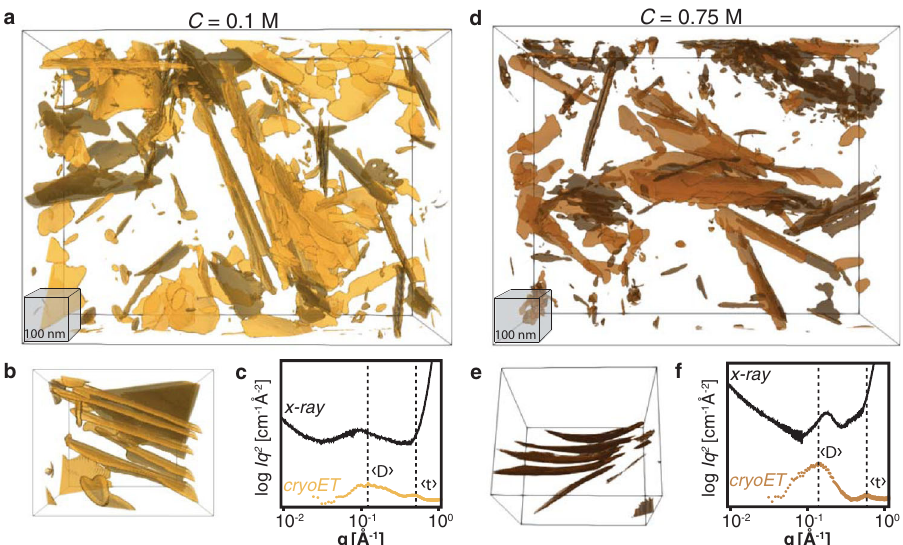
Fig. 3 Li-Mt suspensions viewed with cryoET. Isosurfaces of Li-Mt layers in 0.1 M ( a ) and 0.75 M ( d ) lithium chloride. b , e Subvolumes from ( a ) and ( d ), showing osmotic hydrate stacks. Comparison of structure factors from X-ray scattering and cryoET in 0.1 M ( c ) and 0.75 M ( f ), showing larger average interlayer spacing and larger layer thickness at lower electrolyte